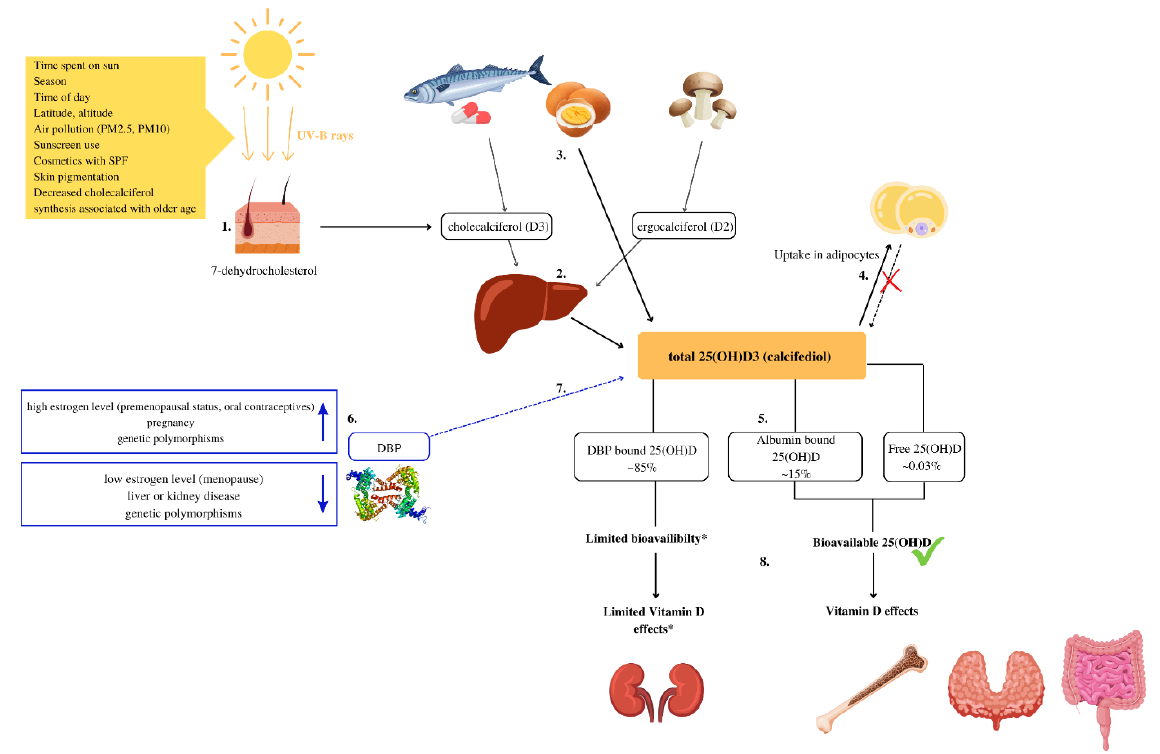
Figure 1. Vitamin D metabolism and bioavailability. (1) Vitamin D is synthesized due to exposure of the skin to UV-B rays from 7-dehidrocholesterol. In the skin, 7-dehydrocholesterol is metabolized into cholecalciferol (D3)[1]. (2) In the liver, cholecalciferol (D3) and ergocalciferol (D2) are metabolized into 25 -Hydroxycholecalciferol (25(OH)D) [1]. (3) Some foods, such as eggs, contain significant amounts of 25(OH)D [2,3]. (4) In obese individuals volumetric dilution of 25(OH)D into the greater volumes of fat, serum, liver, and muscle is probably the most important mechanism that causes lower, serum 25(OH)D in such individuals [4]. (5) In serum, about 0.03% of total 25(OH)D is free, approximately 85% bounds to the vitamin D binding protein (DBP) and 15% to albumin [5]. (6) Several factors can increase or decrease DBP levels and impact 25(OH)D bioavailability[6]. (7) The main biological function of DBP is to extend the plasma half-life of 25(OH)D by decreasing bioavailability [7,8]. (8) Most tissues rely on free and albumin-bound 25(OH)D that are bioavailable and can exert biological activity. * In some cells for example the kidney cells, and likely in the parathyroid gland and placenta cells, DBP-bound vitamin D can be taken up and used [9].